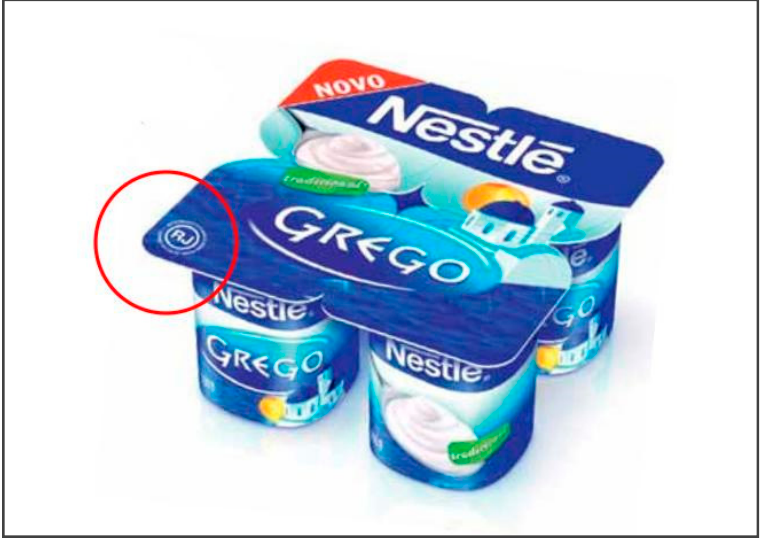
Figure 5. Logo applied to products produced in the State of Rio de Janeiro.